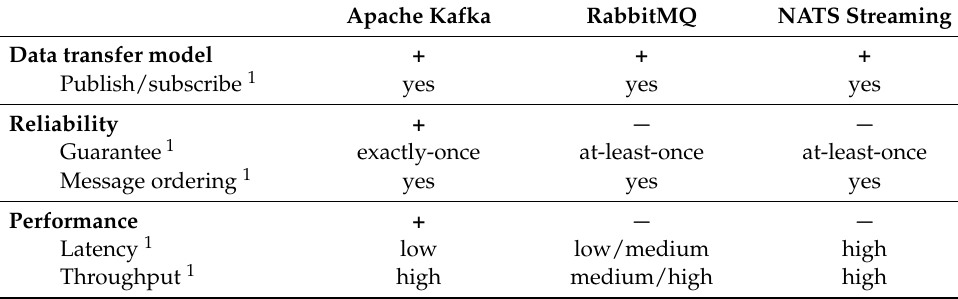
Table 4. Comparison of the considered open-source DMS